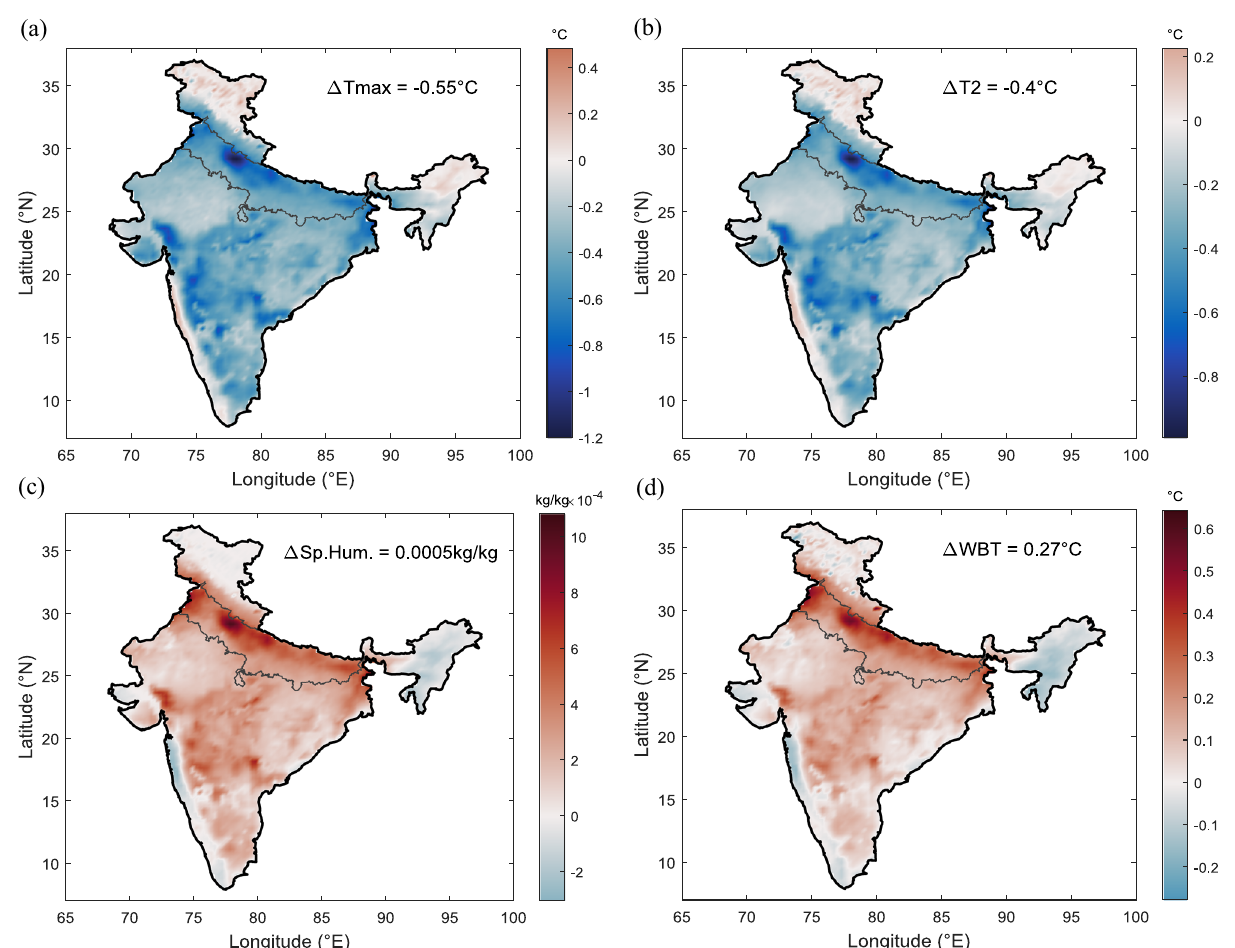
Fig. 3 In fl uence of agricultural census-based irrigation on air temperature, speci fi c humidity, and wet-bulb temperature (Tw). Difference between AGR and CTL experiment during pre-monsoon season (April – May) for the period 2004 – 2016 for a Daily maximum temperature (°C). b Daily mean temperature (°C). c Speci fi c humidity (kg/kg). d Wet-bulb temperature (°C). CTL represents WRF-CLM4 simulation with no irrigation and AGR represents WRF-CLM4 simulation with agricultural census-based irrigation